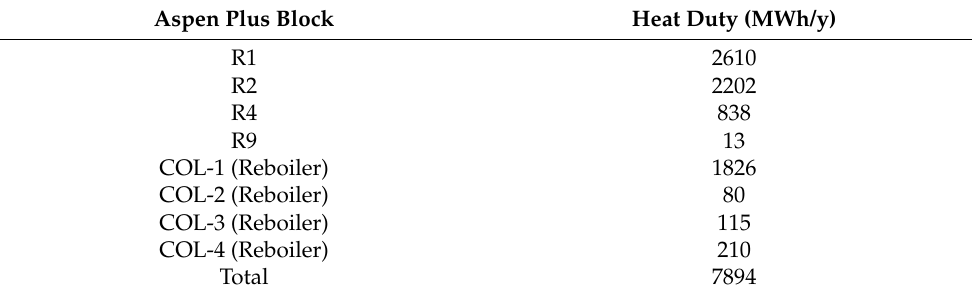
Table 7. Summary of energetic requirements satisfied with the heat of combustion. Aspen Plus